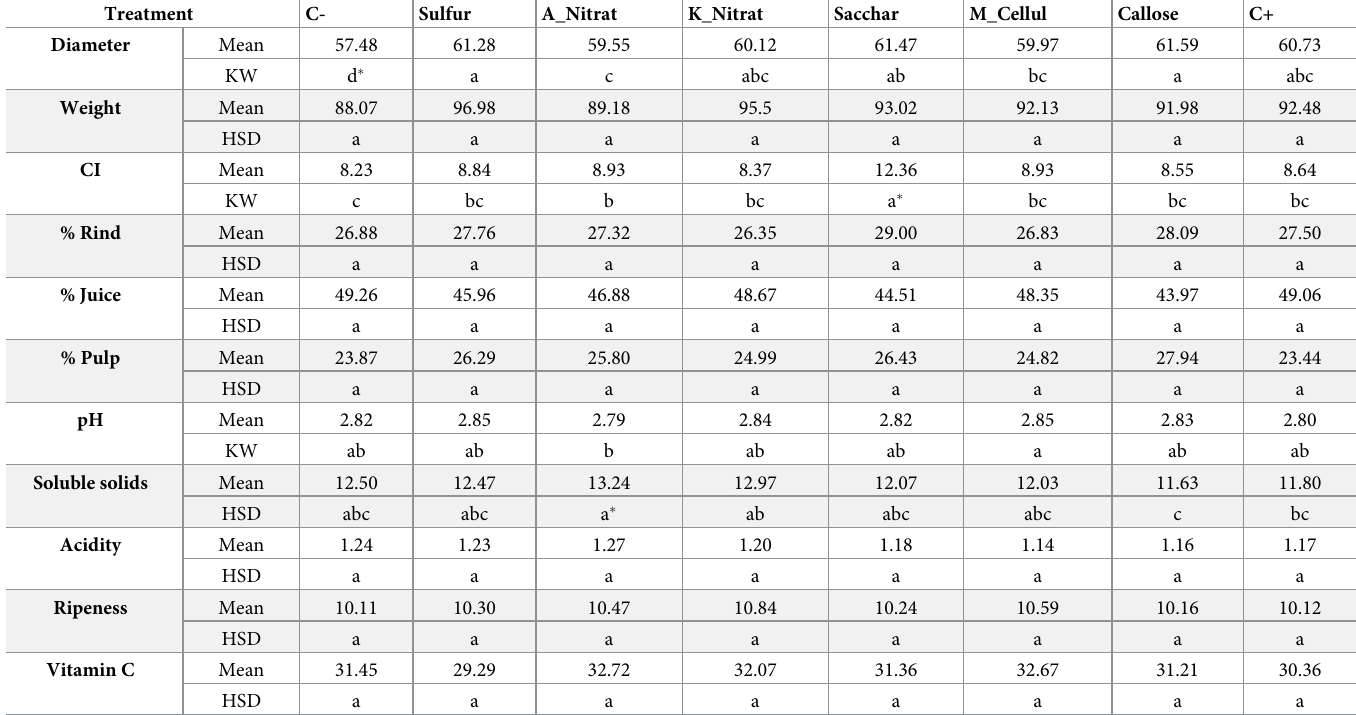
Table 3. Effect of treatment on the fruit quality variables. Treatment